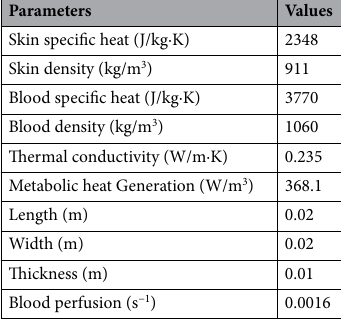
Table 2. Thermal parameters of the skin.